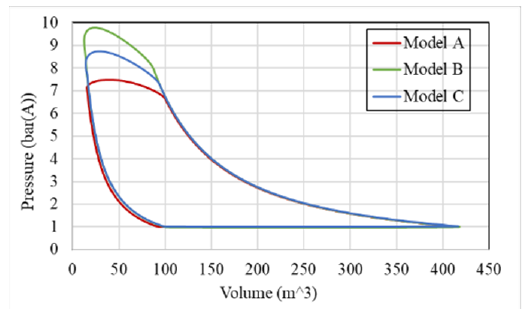
Figure 17 . Comparison of pressure in compressor of three models versus volume .